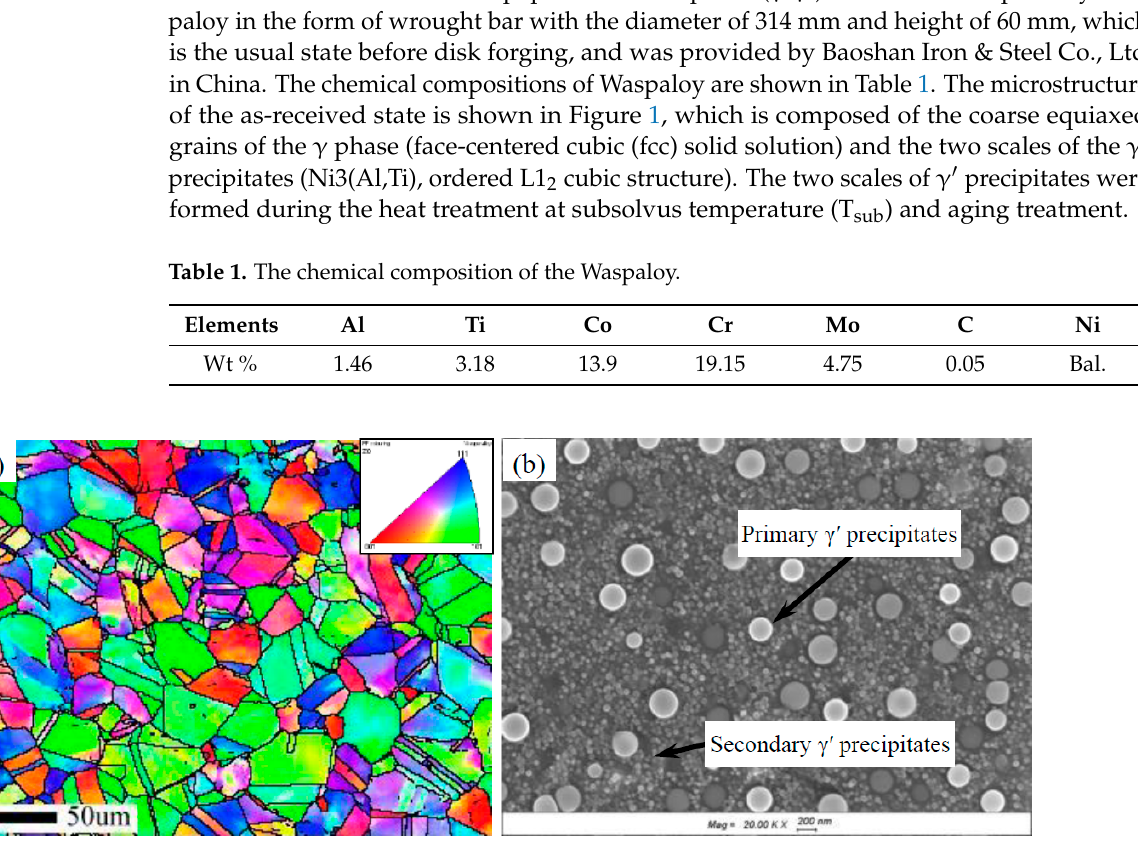
Figure 1. The initial microstructure of the specimen from the wrought bar: ( a ) IPF map showing the homogeneous grains; ( b ) SEM map showing the duplex-sized spherical γ′ precipitates. Table 1. The chemical composition of the Waspaloy.